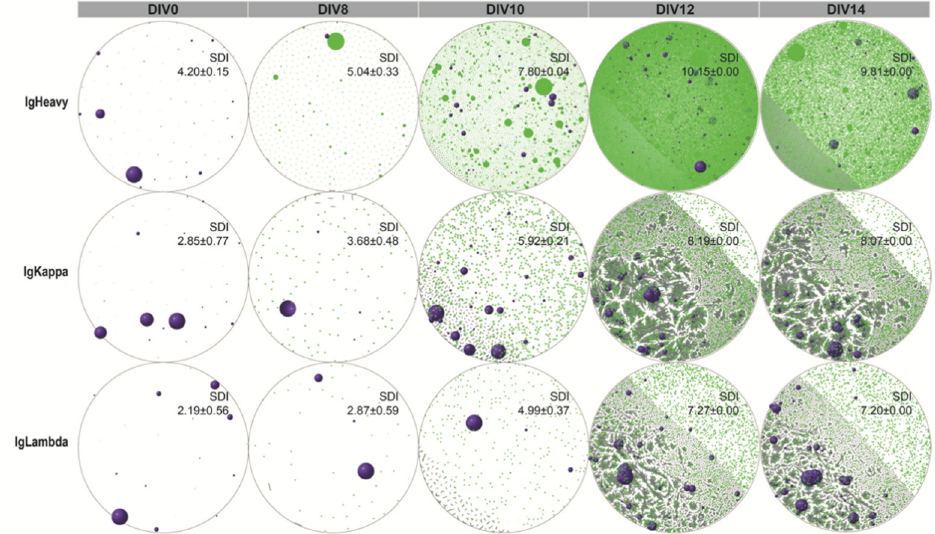
Figure 2. Network plots of human in-vitro hiGC B cells. Purple spheres denote B cell receptor (BCR) clones detected in the original naïve B cell repertoire. Green circles/dots correspond to newly emerged clones. Gray lines connect vertices differing by one nucleotide.